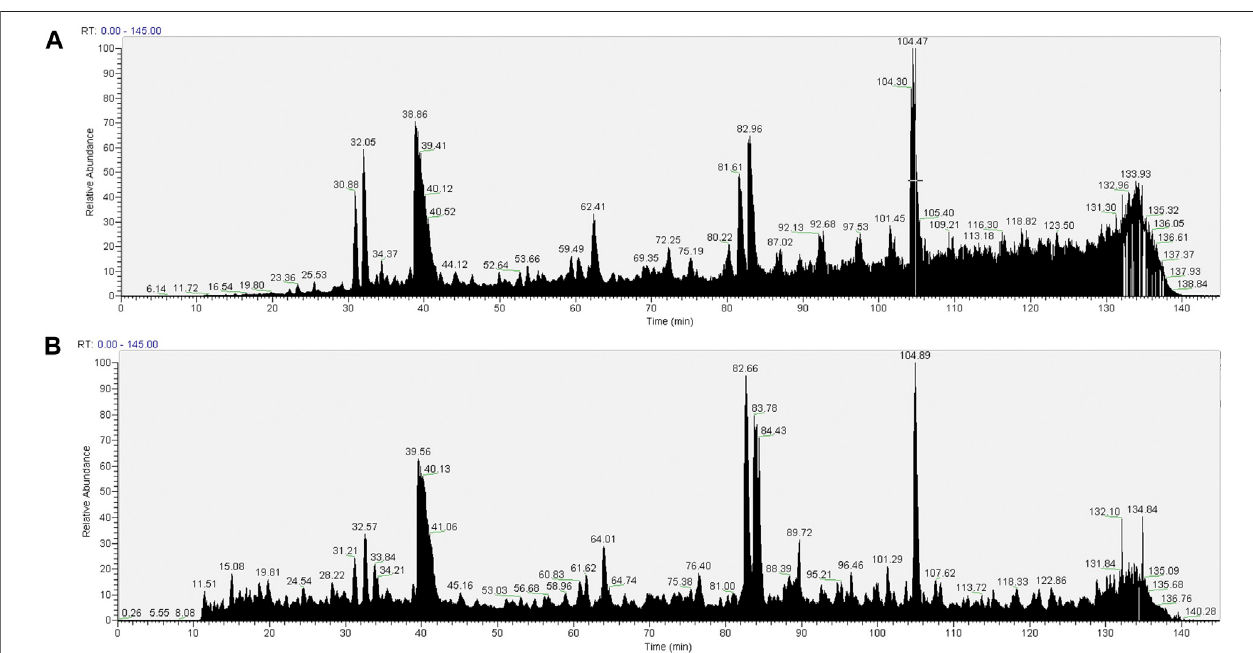
FIGURE 5 | Total ion chromatograms (TICs) of material associated with NeutrAvidin beads following wash procedure 3 [beads were washed with 2 × 1 ml of RIPA, 2 × TBS (TBS: 0.9% NaCl, 10 mM Tris-HCl, pH 7.4; 0.1% Tween 20), 2 × 50 mM CaCl2, 2 × TBS (0.1% Tween 20), 2 × PBS]. Material associated with beads in the pull- downsfrom1.5%SMAsupernatantsorRIPAsupernatantswerereduced,alkylated,andthendigestedfromthebeadswithtrypsin(2.5 µgtrypsin;37 ° C,overnight).The resultingpeptidesweredesaltedusingaSepPakcartridge.PeptideswerefractionatedonanAcclaimPepMapC18reversephaseanalyticalcolumnovera150 min organic gradient, using seven gradient segments. TICs for (A) material in pull-downs from SMA-extracted supernatants and (B) material in pull-downs from RIPA- extracted supernatants are shown.